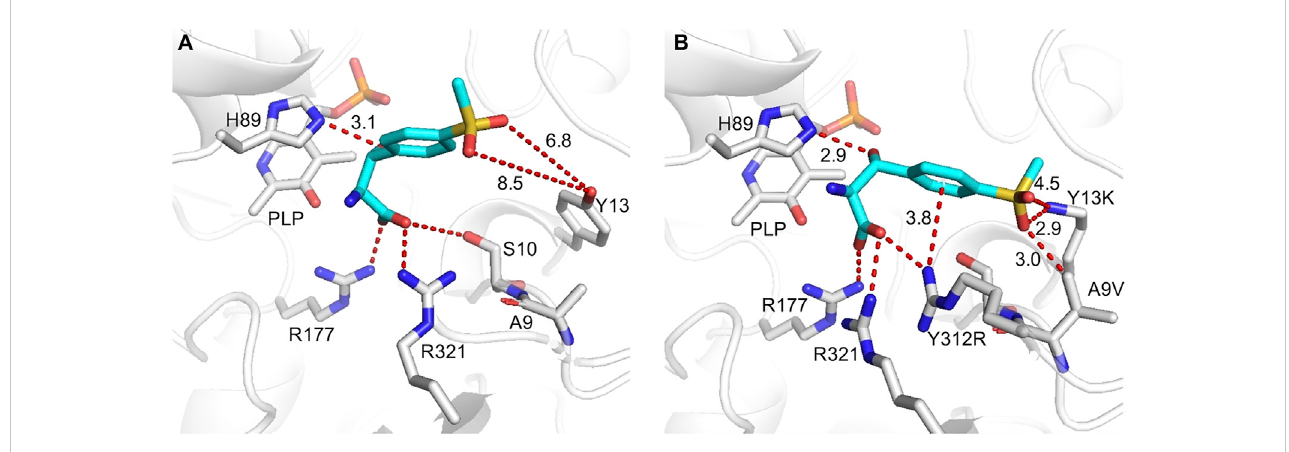
FIGURE 8 Flexible docking results of MSPS (cyan)inWT (A) and A9V/Y13K/Y312R (B) . Active sitesand PLP are displayed ingrey, theinteractions are indicated by red